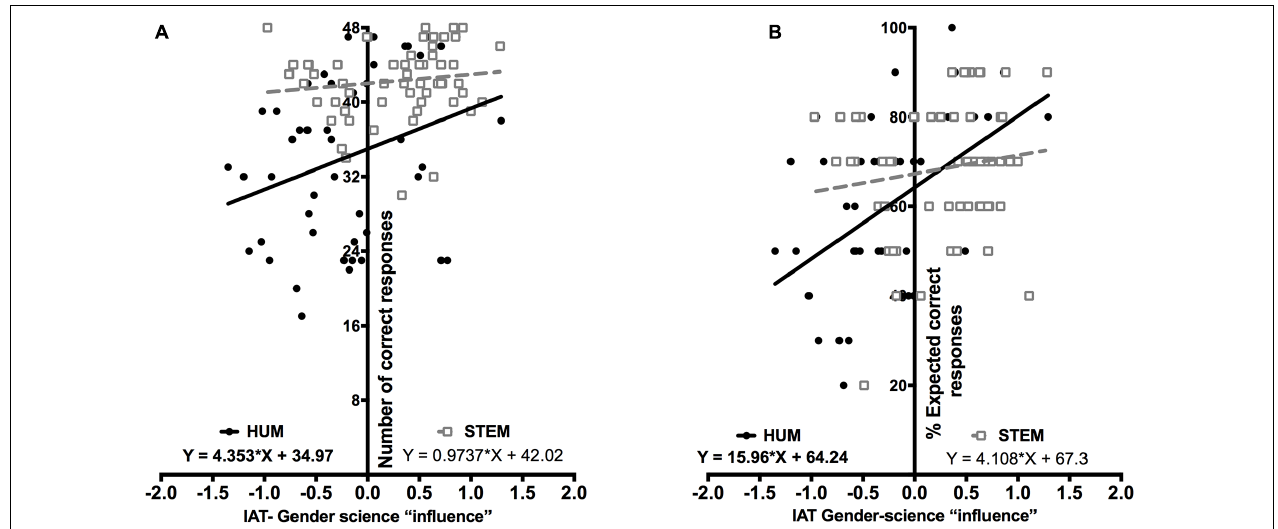
FIGURE 3 | Academic specialization moderates the effects of implicit biases. The data depict individuals’ position in a bivariate space defined by the IAT Gender-Science “influence” ( X -axis) and observed/expected 3DMRT performance ( Y -axis). To assess the statistical moderation of academic specialization on the effects of implicit associations on MRT performance, separate linear regressions were calculated for HUM (black circles) and STEM (white squares) students. In these analyses, the IAT “influence” scores were used as regressors of the 3DMRT observed (B) and expected (A) performance scores. Only the slope of the regression equations of the HUM groups significantly differed from zero (in bold, p < 0.05 and p < 0.01 for observed and expected performance,